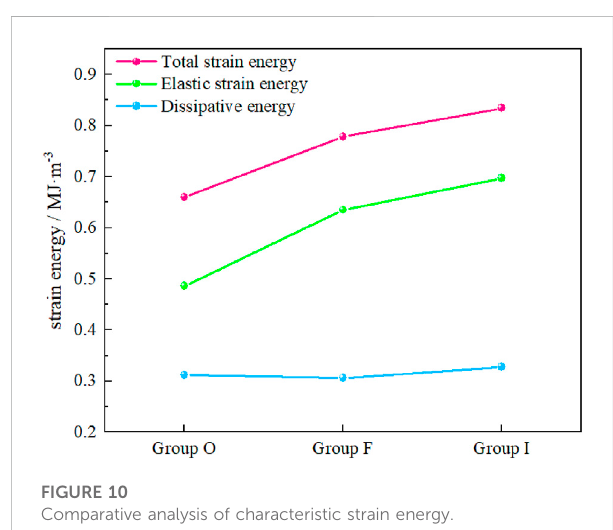
FIGURE 10 Comparative analysis of characteristic strain